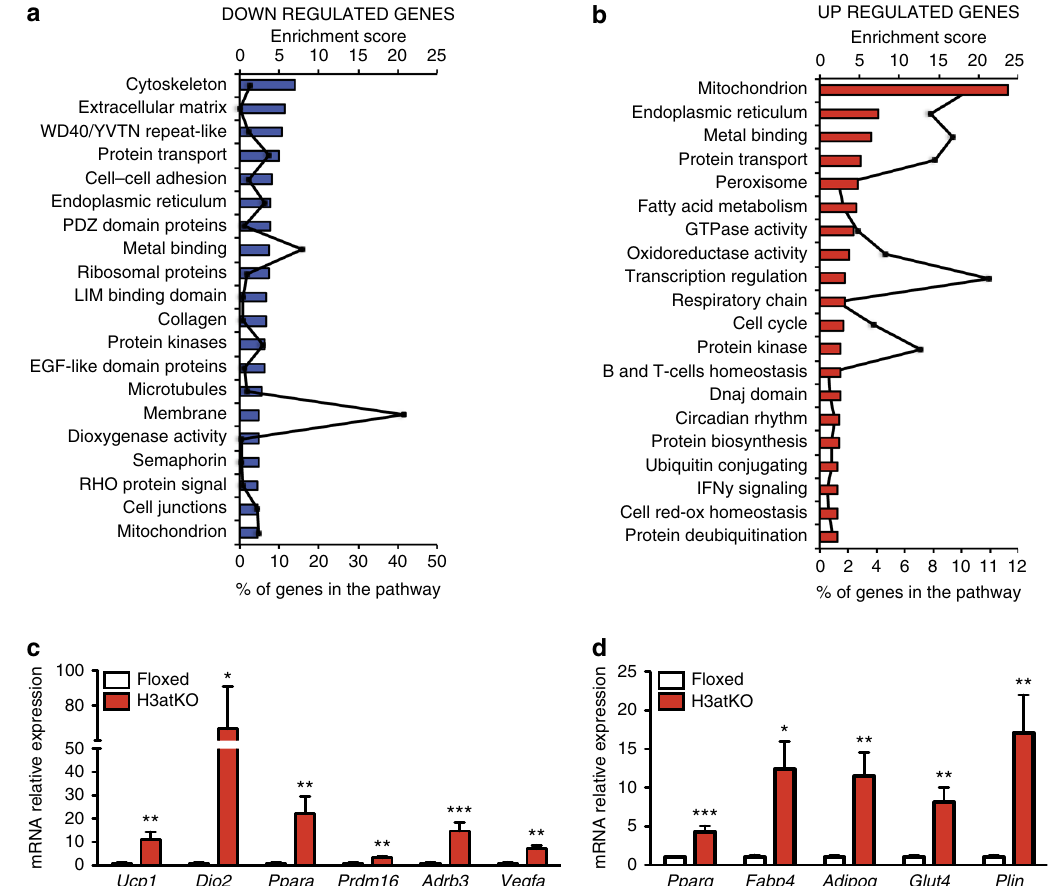
Fig. 2 Differential transcriptome pro fi le in IngWAT of fl oxed vs. H3atKO mice. a Down-regulated pathways in IngWAT of H3atKO mice; b Upregulated pathways in IngWAT of H3atKO mice ( n = 3 per group, where each sample represents a pool from 2 individual mice); c , d qPCR gene expression analysis of browning genes and adipose markers in IngWAT of fl oxed and H3atKO mice ( n = 9 – 11 per group). Data in c and d are presented as mean ± s.e.m. Statistical analysis: Student ’ s t -test, * p < 0.05, ** p < 0.01, and *** p <